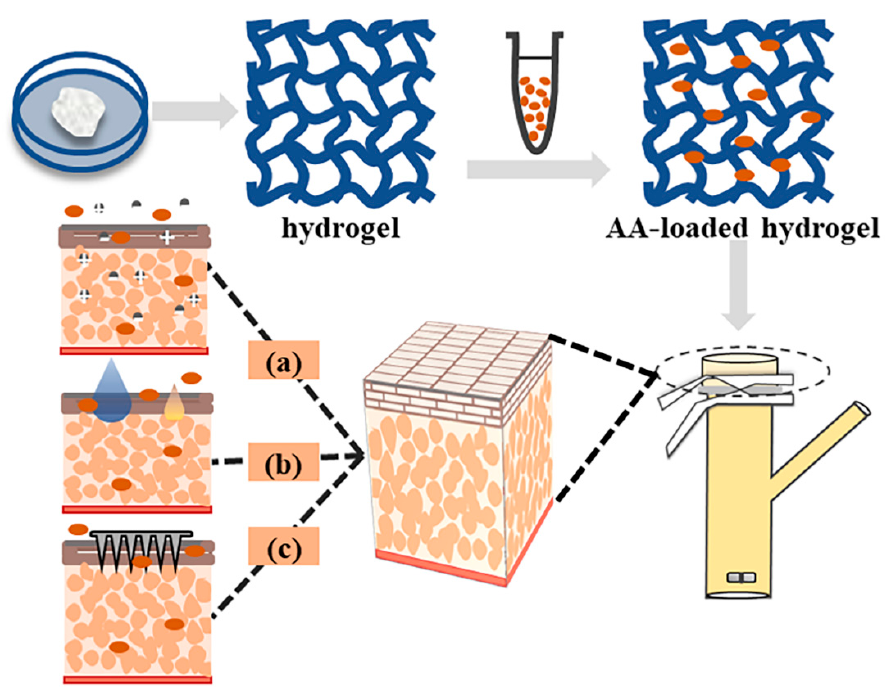
Scheme 1. Schematic diagram of the preparation of AA-loaded hydrogel and study of skin penetration promotion in various ways: ( a ) organic amine counterions; ( b ) chemical enhancers; ( c )